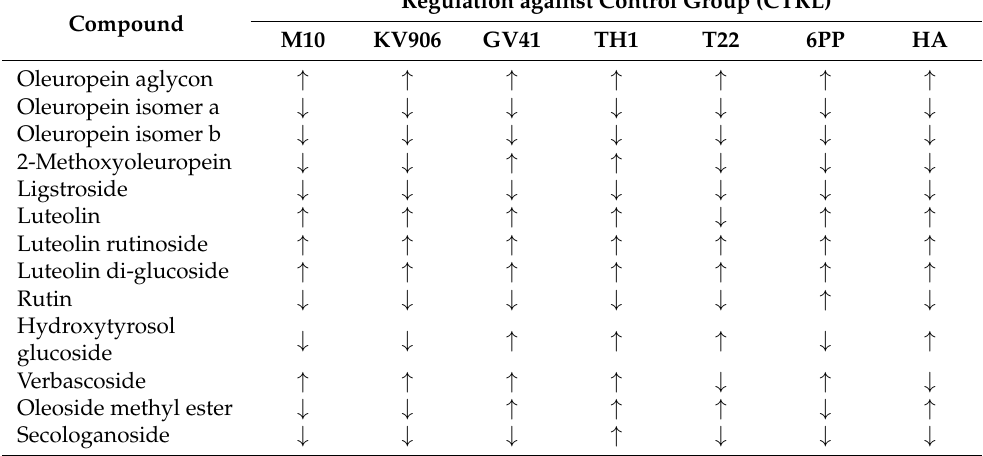
↑ Increased production of the metabolite in treated vs. control. ↓ Decreased production of the metabolite in treated vs. control.